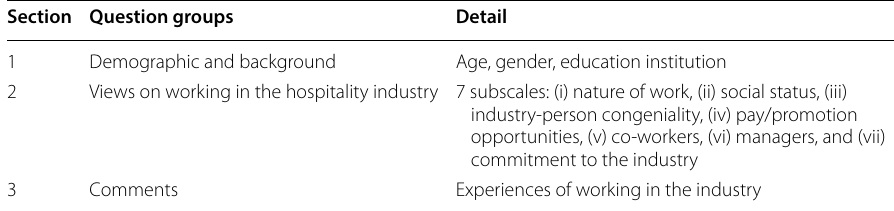
Table 1 Summary of the survey structure Section Question groups